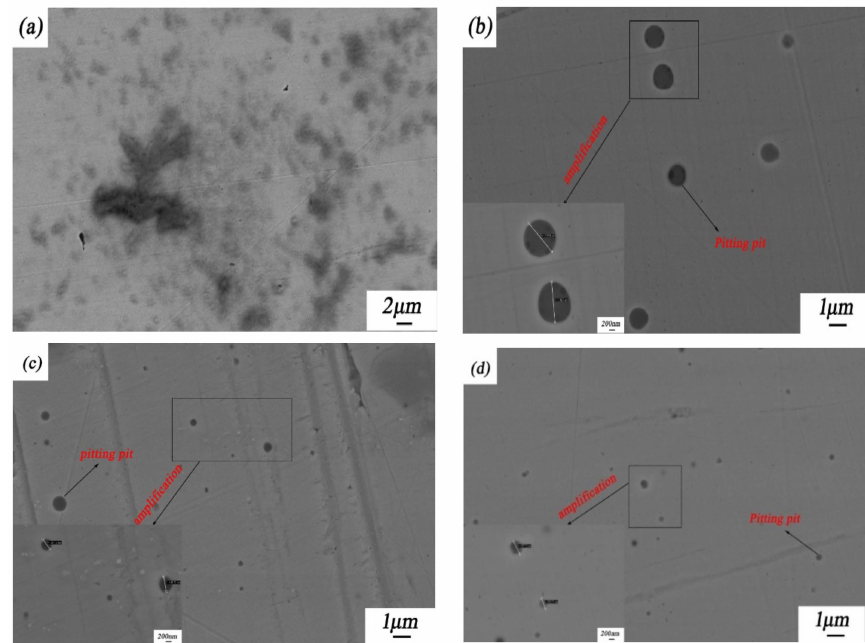
Figure 9. Corrosion morphologies of 316L stainless steel before and after rare earth oxide-modified laser cladding after a 96-h salt spray test: ( a ) 316L stainless steel substrate; ( b ) laser-cladded 316L stainless steel when no rare earth oxides were added; ( c ) laser-cladded 316L stainless steel modified using 2 wt % La 2 O 3 ; and ( d ) laser-cladded 316L stainless steel modified using 2 wt % CeO 2 . The average pit sizes in Figure 9b–d are 11182, 426, and 406 nm,